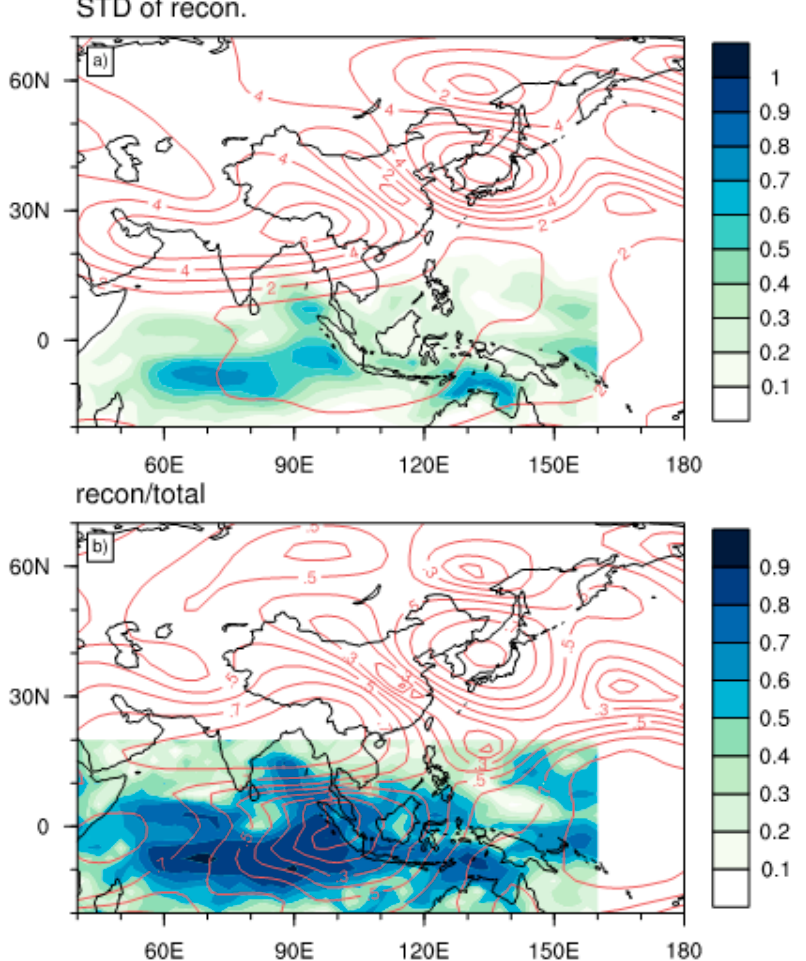
Figure 8. ( a ) Standard deviations of reconstructed (see text) rainfall (shading) and Z200 (contours). ( b ) Ratio between reconstructed and total standard deviations of rainfall (shading) and Z200